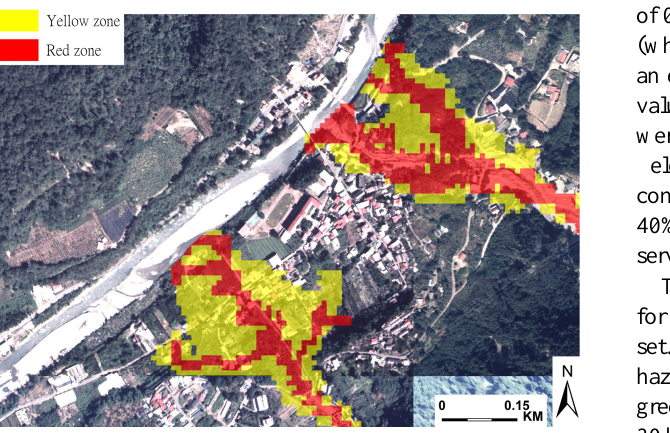
Fig. 2. Distribution of hazard zones for the Nos. 1 and 2 Figure 2. Distribution of hazard zones for the No. 1 and No. 2 Torrents. 3